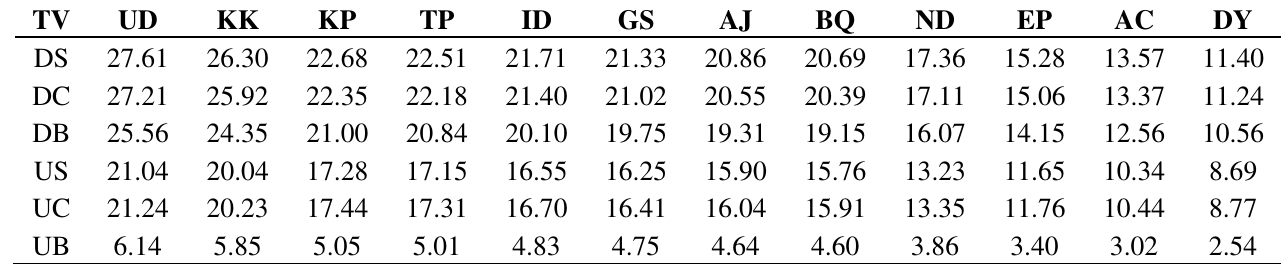
Table 3. Values of (a fertilization on different potato